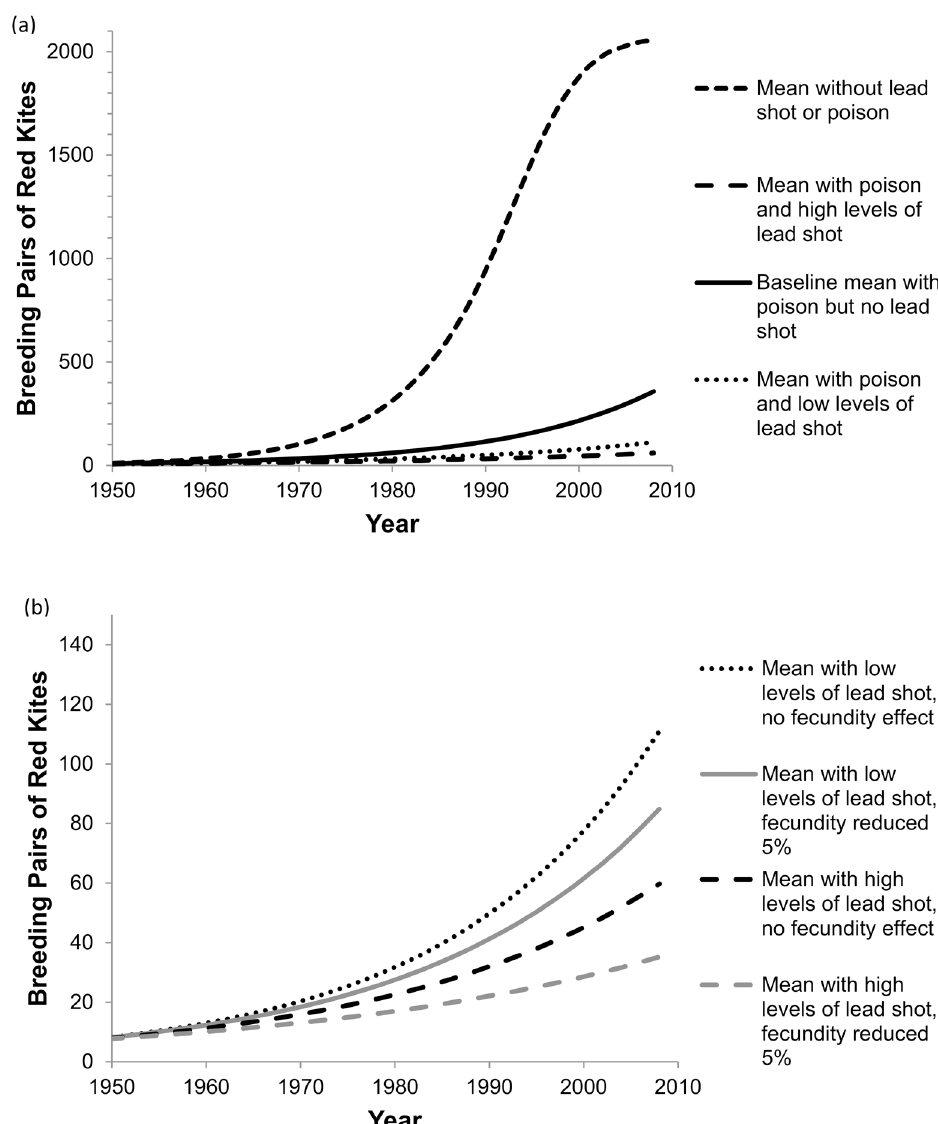
Fig 6. Comparison of red kite mean population trajectories (of 10,000 runs) for various scenarios. (a) Four scenarios shown with or without lead shot ingestion or poison. (b) Sensitivity analysis shown comparing 0 and 5% reduction in fecundity. All scenarios in (b) still include lead shot and poisons affecting mortality but different fecundity effects. Low and high levels of lead shot refers to scenarios of 9% (lower bound) and 16% (upper bound) of total mortality attributable to lead shot ingestion added to the baseline